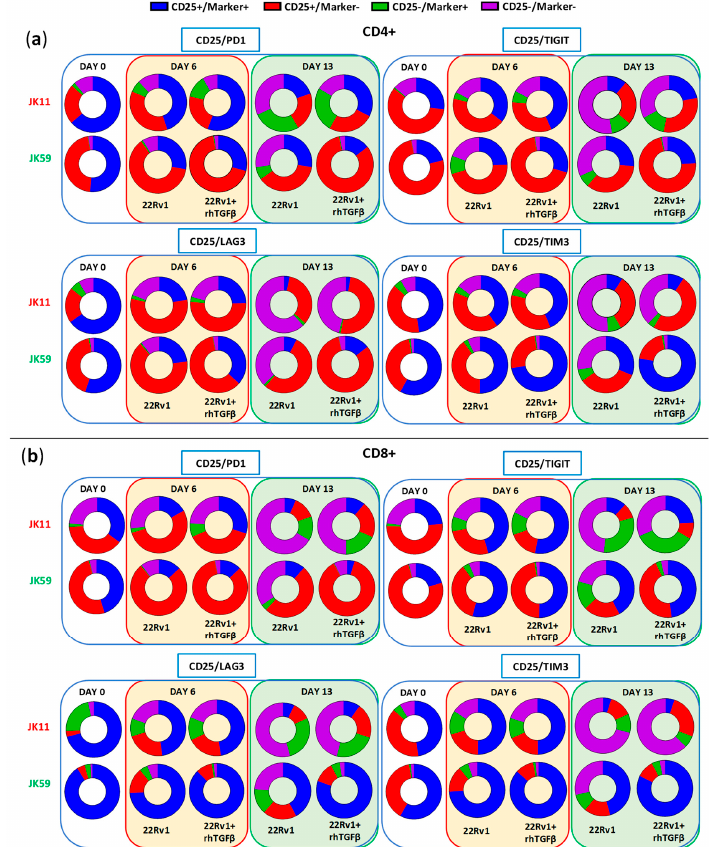
Figure 8. SwR-STEAP1 CAR T cells show a higher polyfunctionality after repeated in vitro stimula- tion of tumor cells. ‘Parts of Whole’ graphs showing the co-expression of the activation maker CD25 with the checkpoint receptors PD1, LAG3, TIM3, and TIGIT on CD4 + ( a ) and CD8 + ( b ) JK11 and JK59 CAR T cells. Samples were collected before the start of long-term co-culture assay (day 0) and at days 6 and 13 of co-culture. T cells were co-cultured with 22Rv1 cells or with 22Rv1 target cells in the presence of rhTGF β (22Rv1 + rhTGF β ). Co-cultures were performed at an E:T ratio of 1:1 (see also Figure 7 and Figure S8). Average expression values from the two healthy donors of the long-term co-culture assay were used. Each co-culture from each donor was performed in